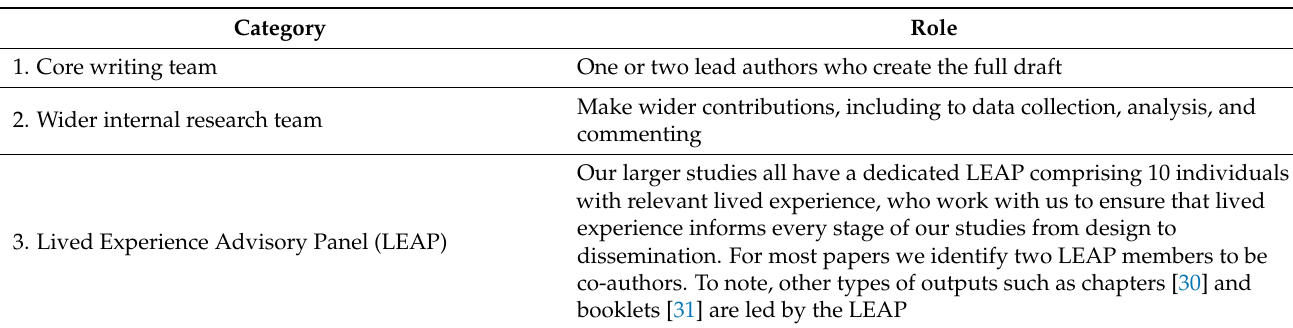
Table 3. Categories of